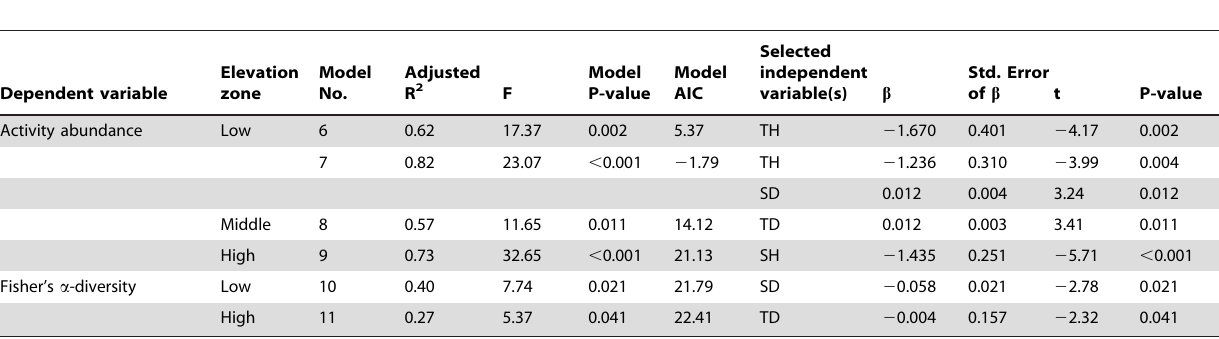
Table 2. Results of stepwise linear regressions for the three elevational zones using activity abundance and Fisher’s a -diversity of carabids as dependent variables and vegetation parameters as independent